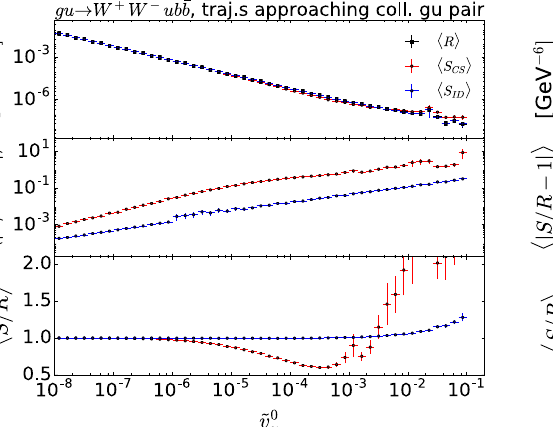
Table 1 NLO cross sections for e + e − → W + W − b ¯ b at μ R = m t and varying center-of-mass energy, computed using standard CS subtrac- tion terms (CS) or pseudo-dipoles (ID). The subtracted real-emission